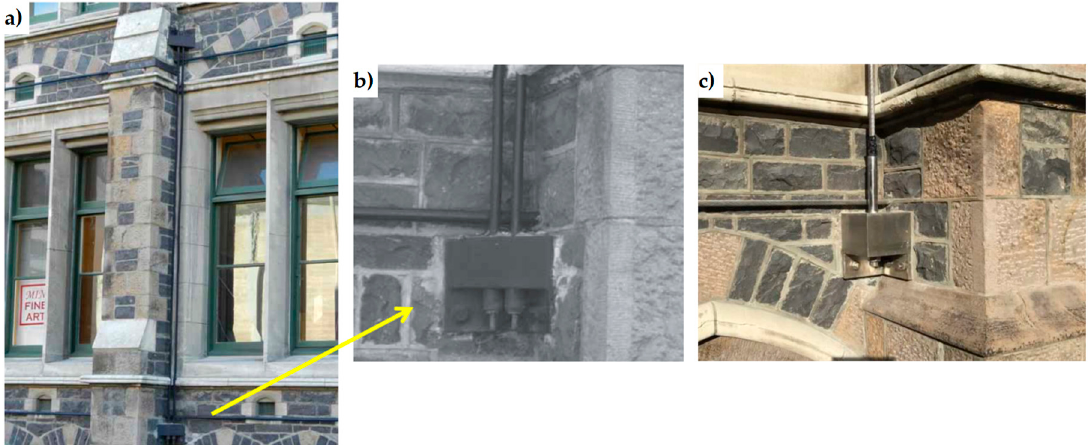
Figure 6. Christchurch Arts Centre, Chemistry building: a ) external vertical cables connected to the structure through junction boxes, to increase the compression caused by gravity loads and ensure that the wall stays in overall compression during shaking; b ) retrofit dating back to 1984, with pairs of external unbonded tendons; c ) post ‐ earthquake retrofit, with a stainless steel cable.